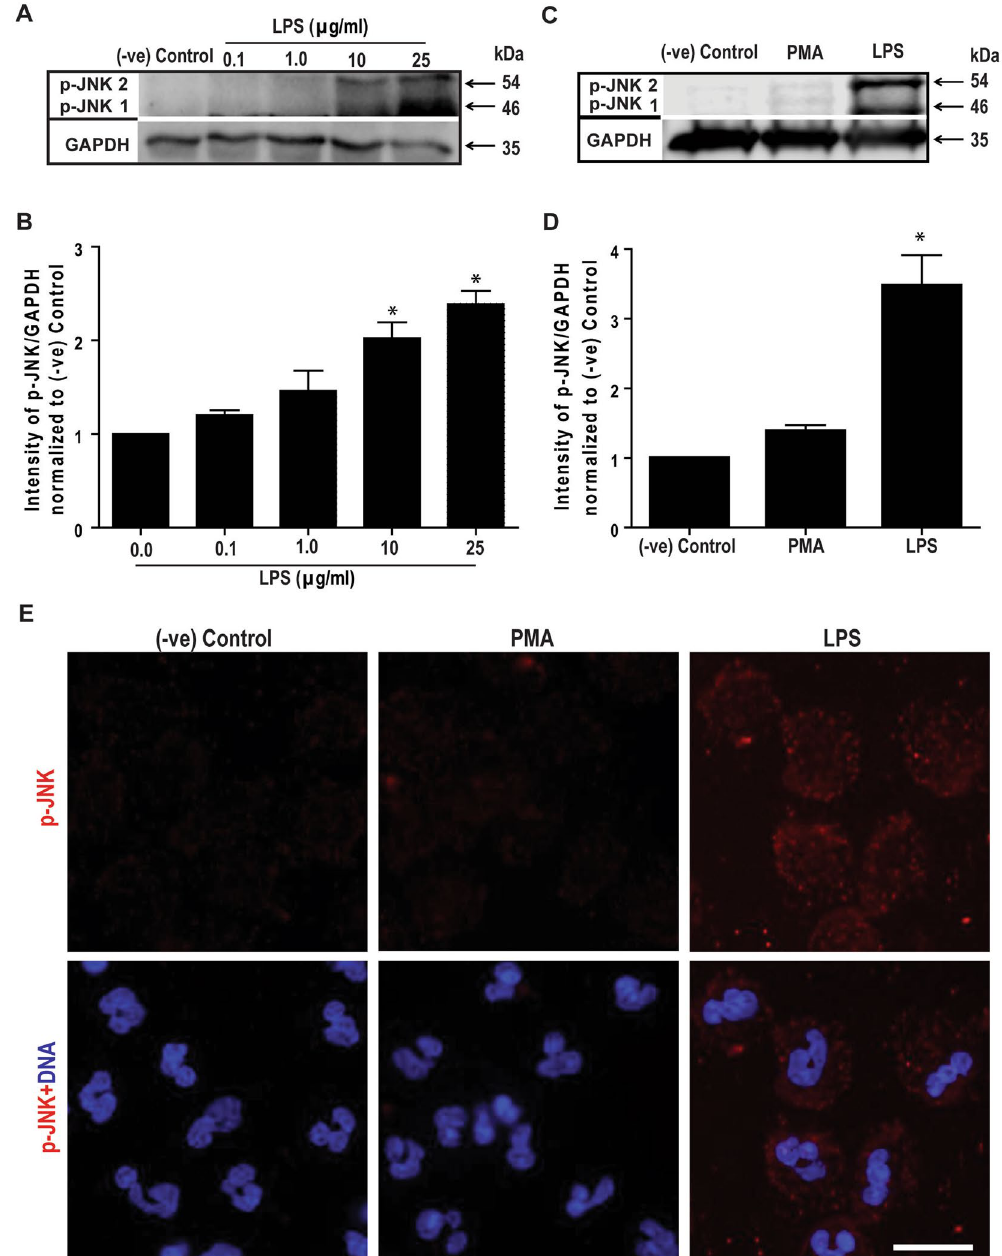
Figure 1. LPS, but not PMA, dose-dependently activates JNK in human neutrophils . ( A ) Human neutrophils were stimulated with E. coli LPS (0111:B4; 0, 0.1, 1.0, 10, 25 μ g/ml) for 30 min, and lyzed for Western blot analyses. Immunoblots show an LPS dose-dependent phosphorylation of JNK (p-JNK). GAPDH blots were used as loading controls (n = 3). ( B ) The densitometry analyses show the significant dose-dependent increase of the JNK activation in LPS (10 and 25 μ g/ml) treated neutrophils. The values were normalized to the negative control values of the same experiment ( * indicates p-value < 0.05; One-sample t test compare to hypothetical value 1). ( C ) Human neutrophils were stimulated with media (-ve control), PMA (25 nM) or LPS (25 μ g/ml) for 30 minutes. Immunoblots show that LPS, but not PMA activates JNK in neutrophils. GAPDH blots were used as loading controls (n = 5). ( D ) The densitometry and statistical analyses were conducted for C , as of B . Total JNK1 and JNK 2 levels do not change within 30-minute incubation period (Supplementary Fig. S1). Error bars in all the panels represent SEM. ( E ) Confocal microscopy images of the neutrophils immunostained with p-JNK (red), and DNA (blue) after 30 min of NETosis induction, confirm the increased activation of JNK in LPS-, but not PMA-mediated NETosis (n = 3; scale bar 25 μ m). See the full Western blots in Supplementary Fig.